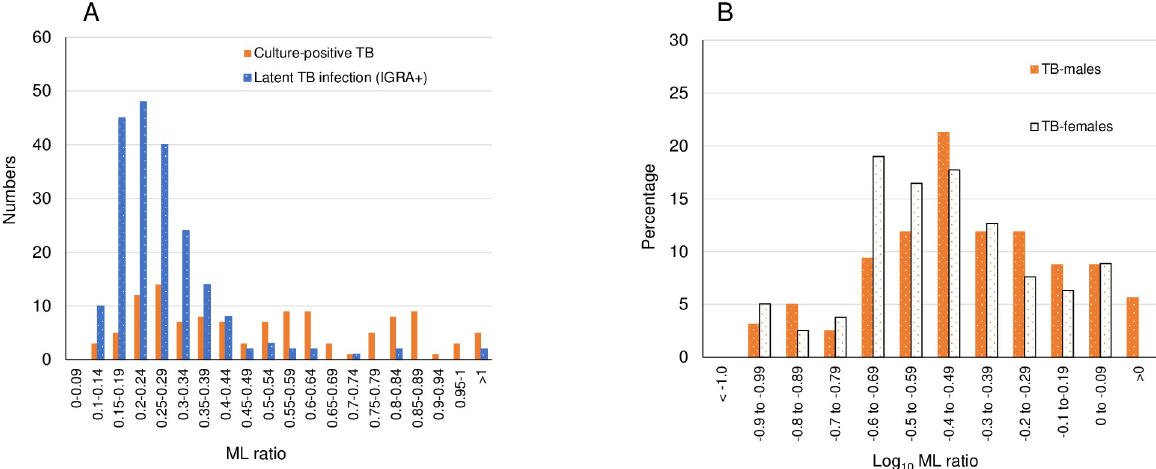
Fig 2. Monocyte-to-lymphocyte ratios (MLRs) and spectrum of tuberculosis (3-year cohort). A. MLRs in patients with culture-positive tuberculosis and screened individuals with a positive interferon-gamma release assay but no active tuberculosis. This shows a right-sided skew of data. B. Log-transformed MLRs in patients with tuberculosis related to